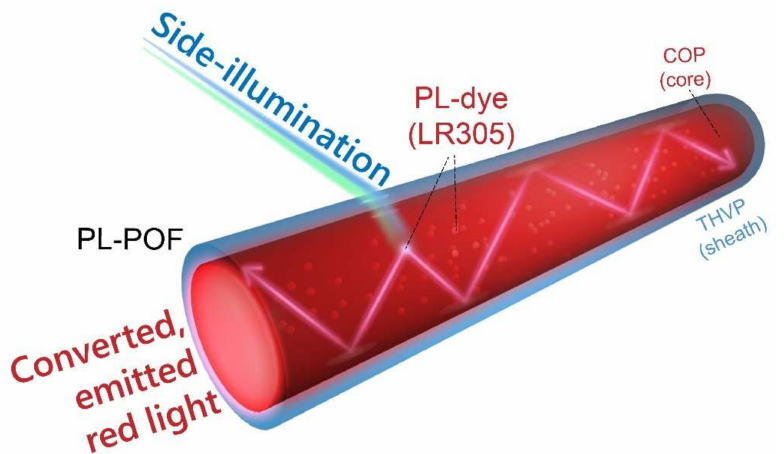
Figure 1. Down-conversion of incoming light from side-illumination of a PL-POF into axially emitted red light. The PL dye (LR305) in the core of the PL-POF is responsible for the light conversion from blue to red. Reprinted/adapted image with permission from [15]. 2020,